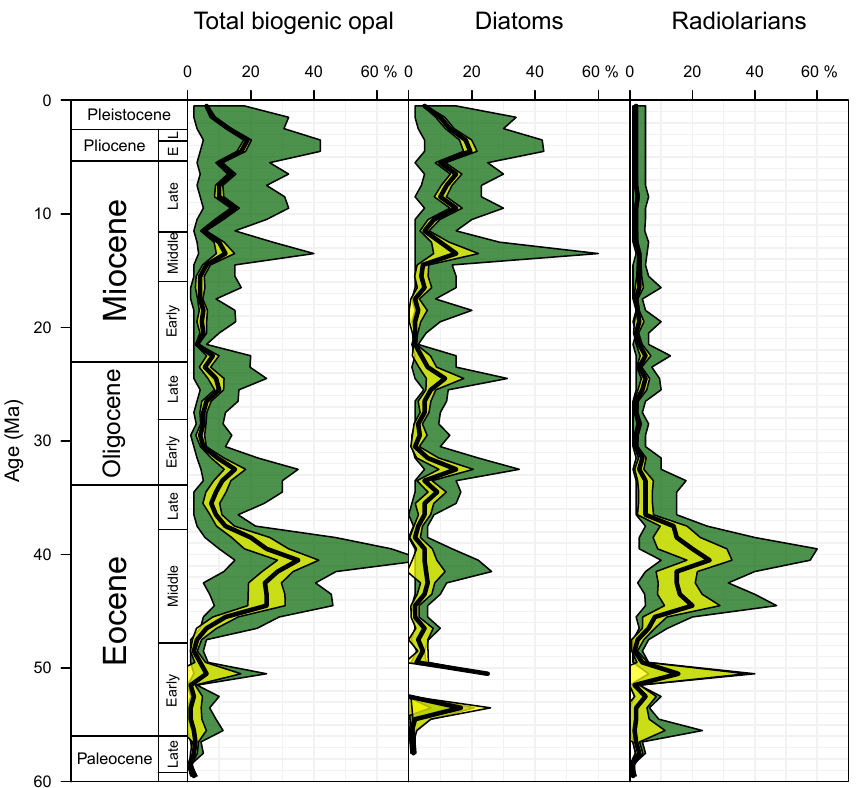
Figure 3. History of biogenic opal deposition. Left panel: total biogenic opal in DSDP–ODP smear slides (diatoms, radiolarians, silicoflag- ellates and sponge spicules combined). Middle panel: global abundance of diatoms. Right panel: global abundance of radiolarians. The bold black line is the median value in each 1Myr time bin, while the yellow envelope delimits the 95% confidence interval on the median and the green envelope the interquartile range of the